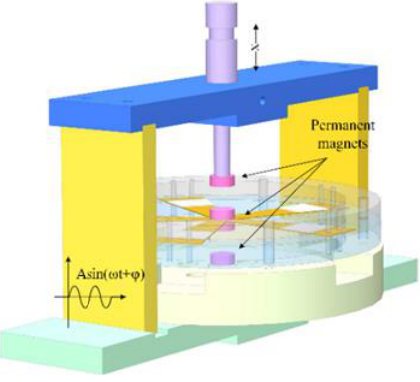
Figure 9. Simplified model of SPEH with external holder for magnetic field experiment.